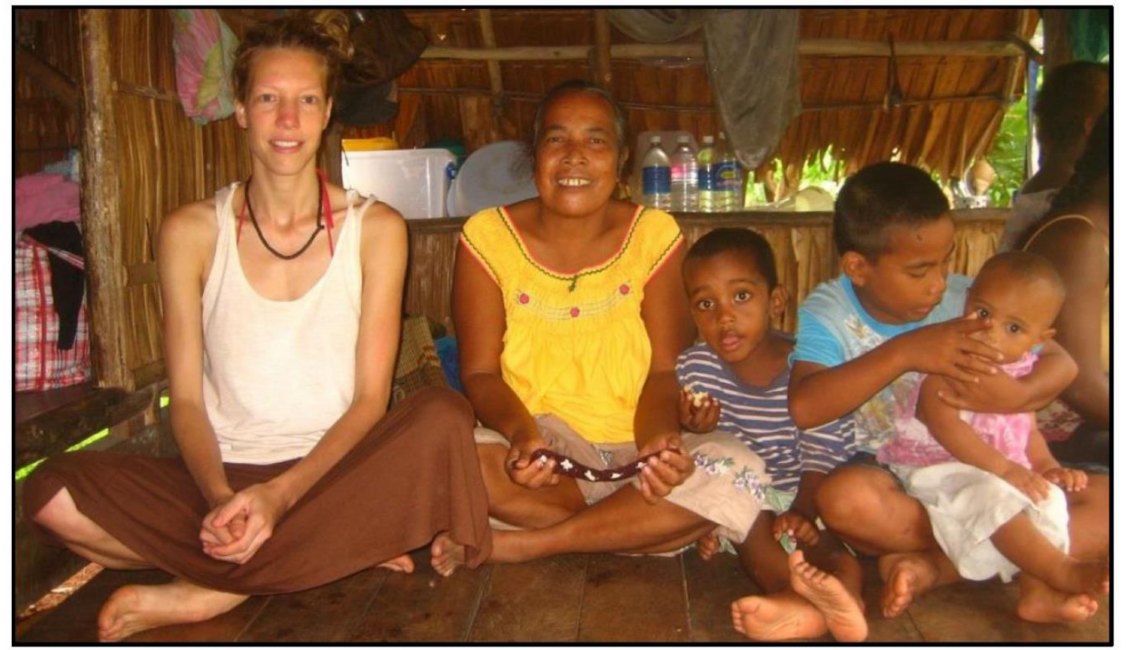
Figure 4. Lead author Kim Hagen (left) with a Gilbertese family in a research village setting on Ghizo. This research involved spending extensive periods of time with communities that were impacted by the tsunami. This allowed for a deep understanding and respect to develop between researcher and community.